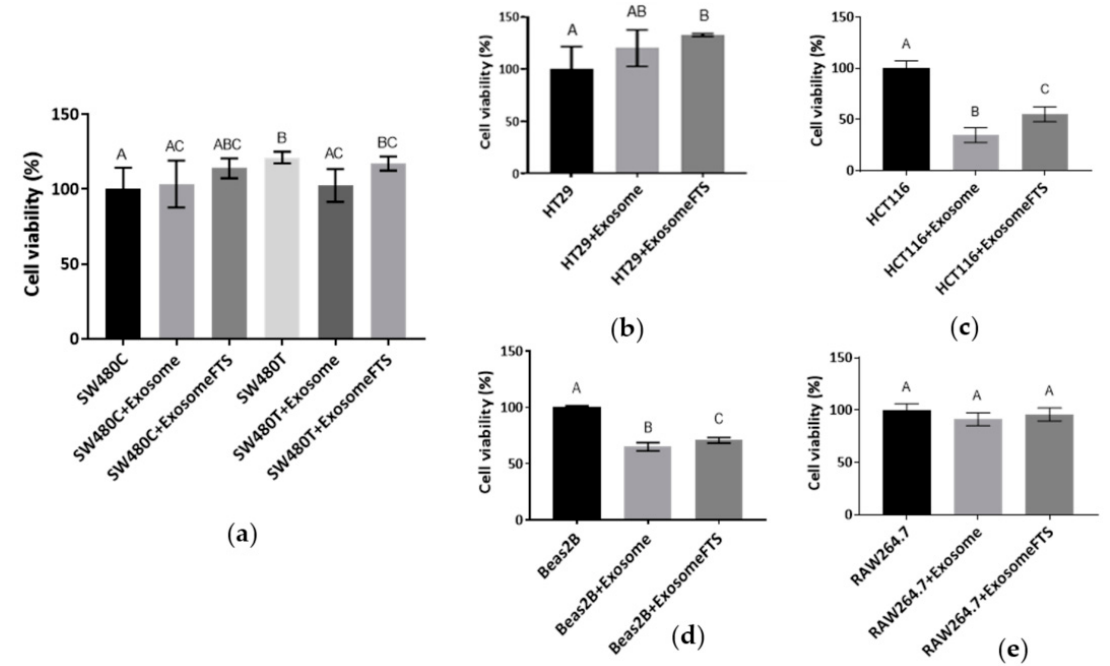
Figure 7. Viability of various cell types with uptake of exosomes derived by SW480 cells after 24 h of incubation (SW480C—Control cells; SW480T—FTS-treated cells; Exosome—Exosomes derived by SW480C; ExosomeFTS—Exosomes derived by SW480T). The viability of cell lines ( a ) SW480, ( b ) HT29, ( c ) HCT116, ( d ) Beas2B and ( e ) RAW264.7 was determined using MTT assay. Means with different letters indicate a significant difference between groups ( n = 3, p < 0.05; one-way ANOVA-Tukey’s multiple comparison tests).